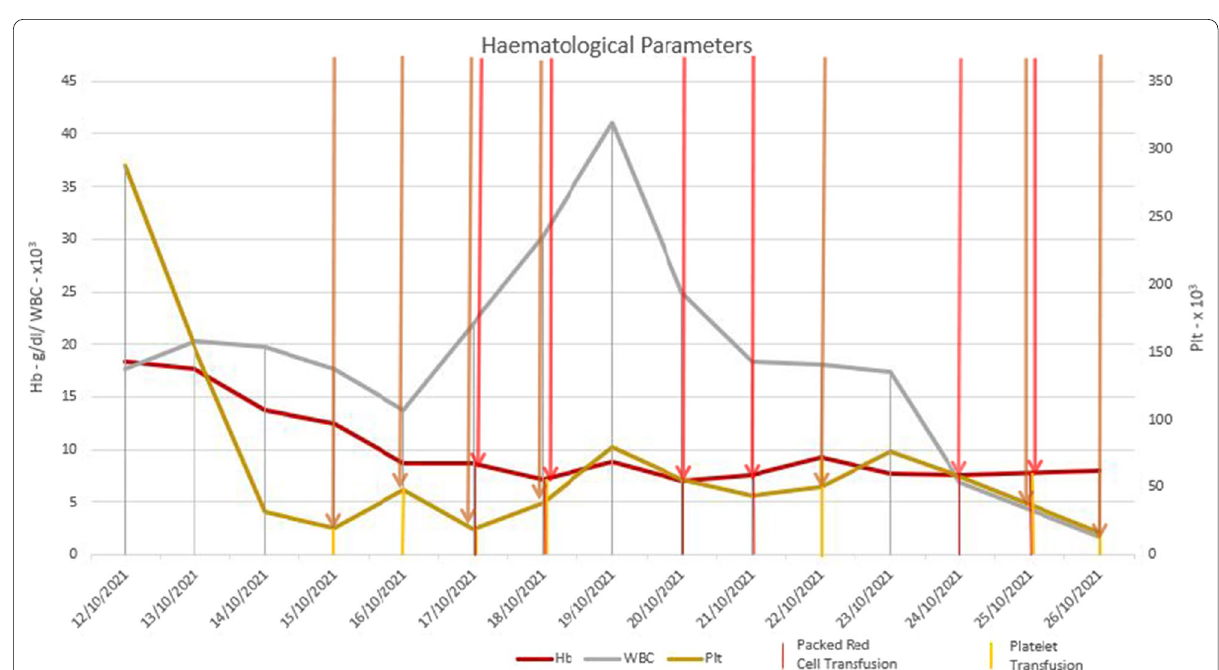
Fig. 4 Progression of haematological parameters during the ICU stay. Blood and platelet transfusions are indicated by the red and yellow lines. The transaminase levels dropped progressively, but the bilirubin levels were rising. Thrombocytopenia and haemolysis persisted even after the coagulopathy was